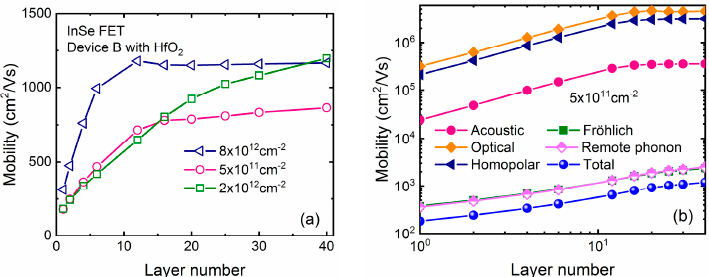
Figure 6. ( a ) Mobility as a function of number of layers ranging from 1 to 40 with different inversion density in InSe FET using HfO 2 as gate dielectric and SiO 2 as substrate, as shown in Figure 1b. ( b ) Contributions of each scattering mechanism to the total mobility at low inversion density.